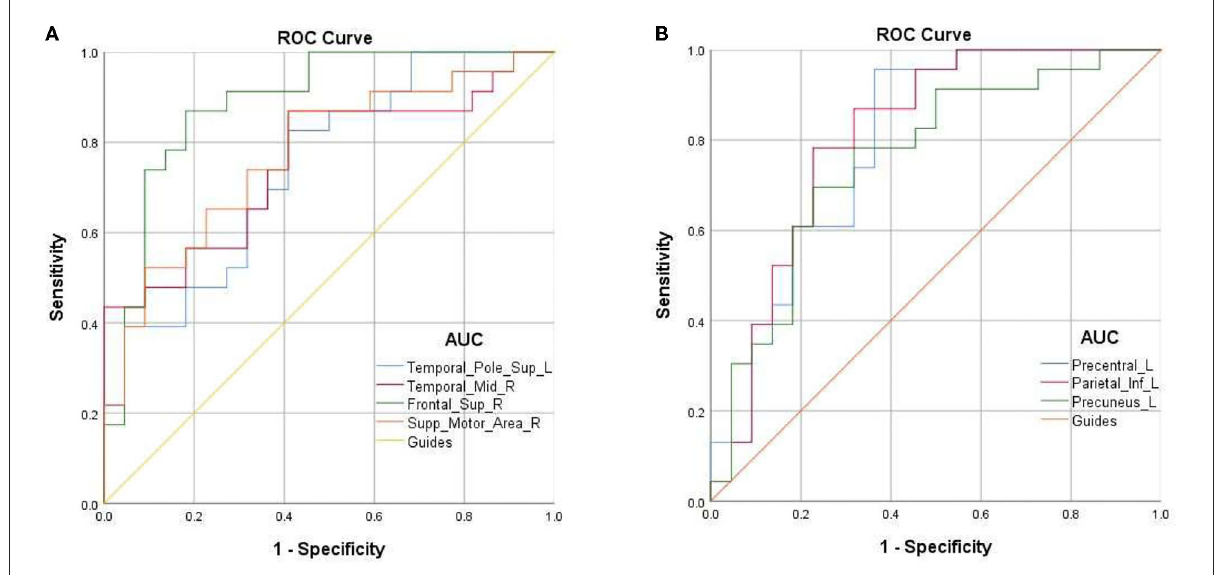
FIGURE3 ROC curve analysis for the mean fALFF values of altered brain regions. (A) The area under ROC curve was 0.745 for Temporal-Pole-Sup-L ( p = 0.005, 95%CI:0.603–0.887); 0.755 for Temporal-Mid-R ( p = 0.003, 95%CI:0.621–0.898); 0.887 for Frontal-Sup-R ( p < 0.001, 95%CI: